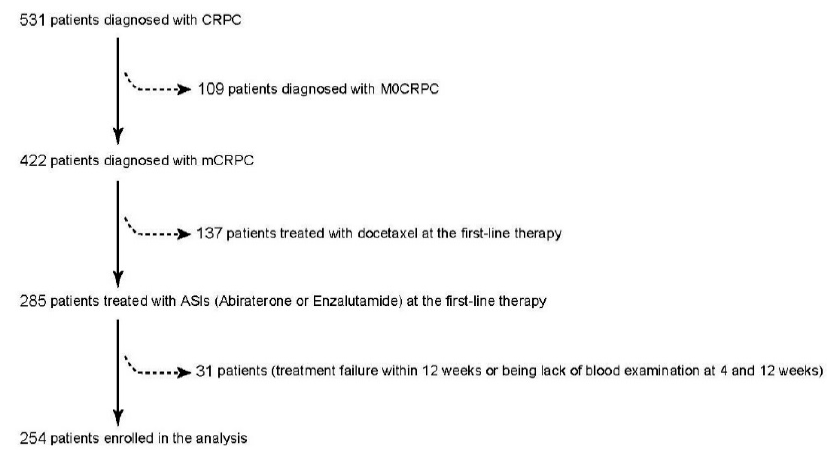
Figure 1. Study design in the current study. A total of 254 mCRPC patients treated with first-line abiraterone acetate (AA) or enzalutamide (Enz) were analyzed.